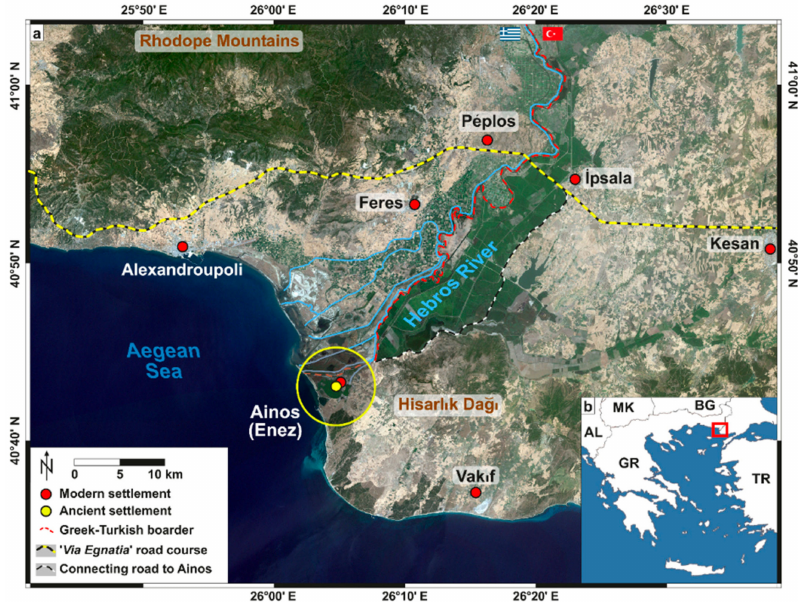
Figure 1. Research area at the border between Turkey and Greece. ( a ) Overview map (based on Landsat 8; acquired 13 June 2014; composition of bands 4, 3, 1) with locations mentioned in the text; ( b ) position of 1a on a general map of the Aegean